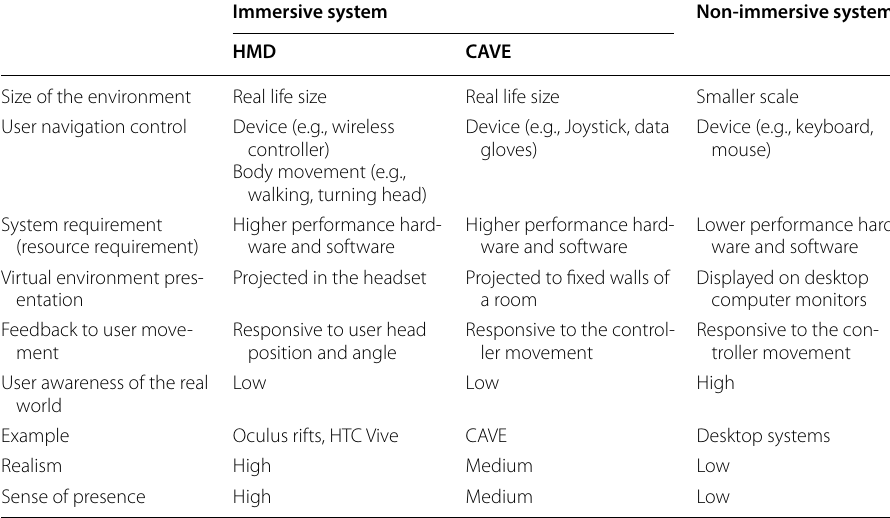
Table 1 Characteristics of VR